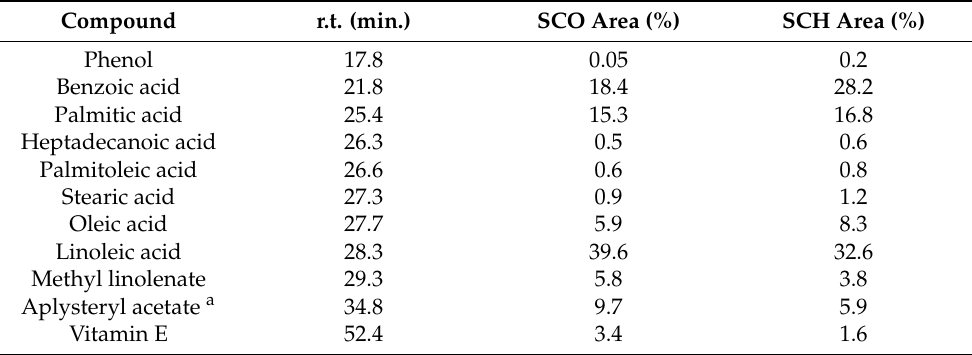
Table 1. Relative % areas of the GC–MS peaks for common components identified in “Rubra Plena” ( SCO ) and “Pink Hawaiian Coral” ( SCH )